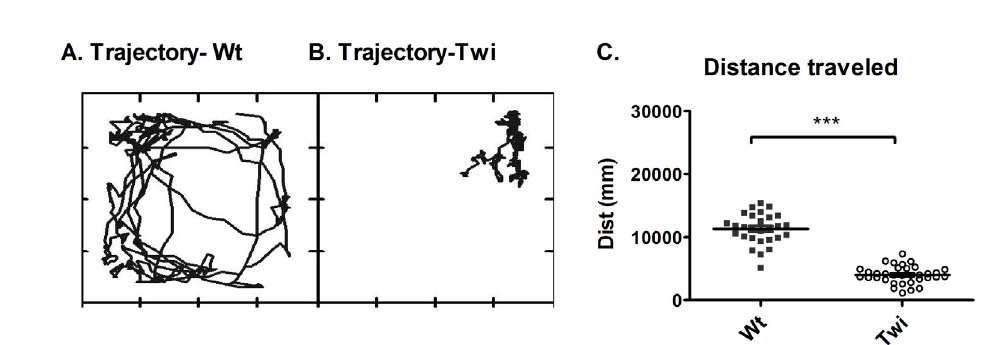
Figure 2. Characterization of locomotor activity in the twitcher mouse. The movement trajectory of representative Wt and Twi mice are shown in ( A ) and ( B ), respectively. Each panel represents the movement of the mouse for duration of 1 min. The box in which each movement trajectory is plotted represents the inside wall of the 20 cm × 20 cm cage that confined the mouse to the load plate. Each point in the panel represents the XY location of the mouse at a certain point of time. The total distance traveled during 6 min is shown in ( C ). The total distance traveled by the Wt mice (filled squares) is significantly higher than that of the Twi mice (open circles). The horizontal bars represent the mean and the error bars represent the SEM (*** p <